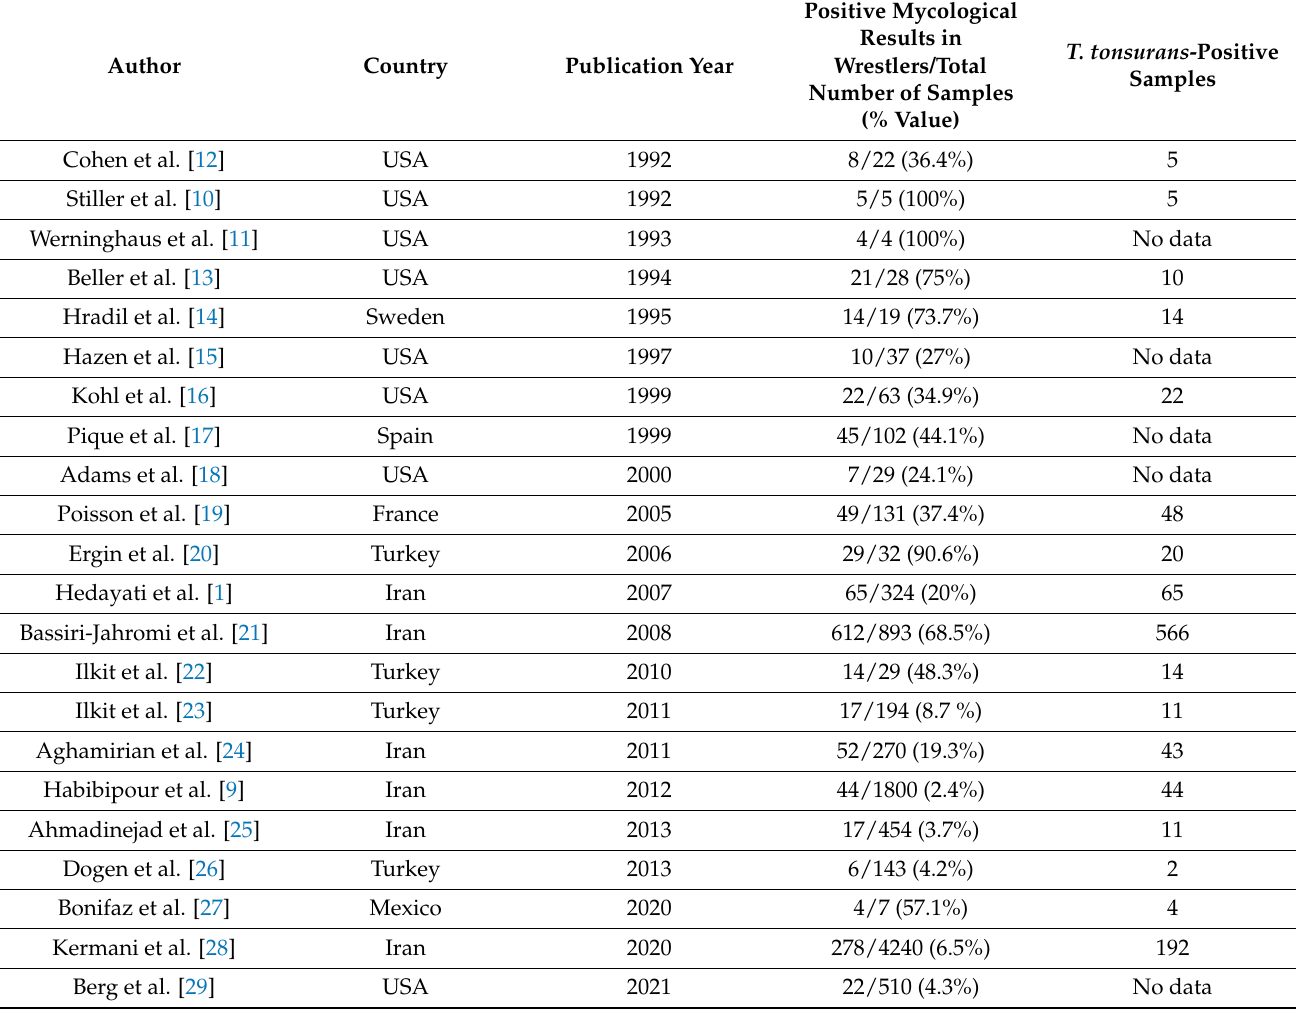
Table 1. Tinea gladiatorum (TG) frequency among contact sports